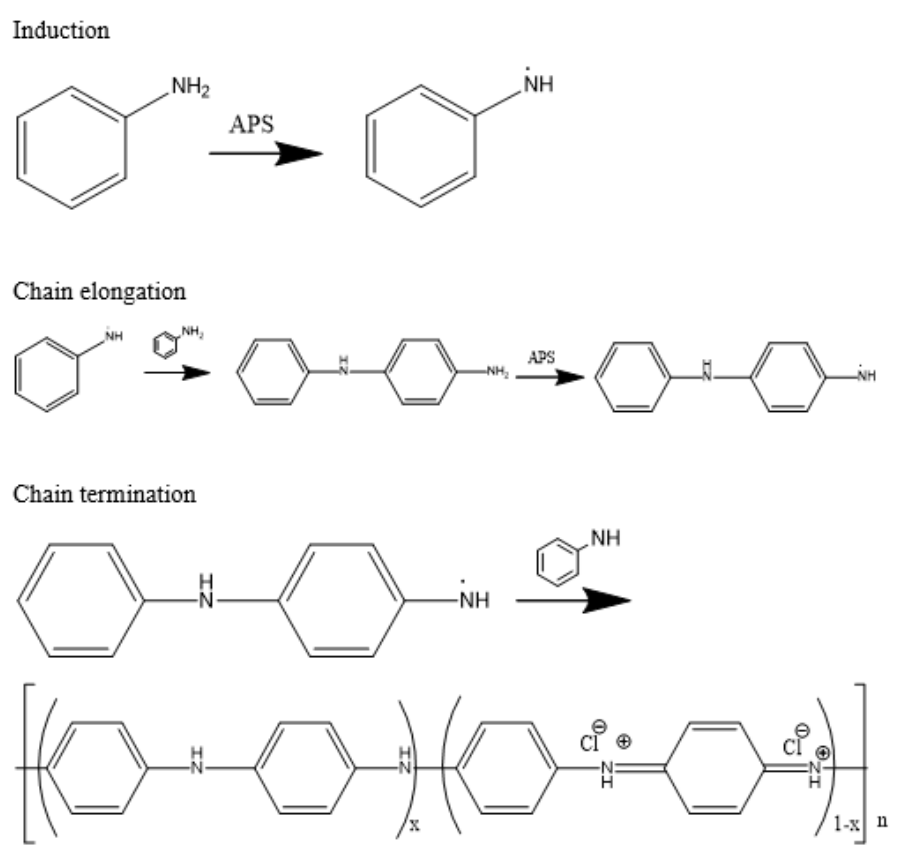
Figure 5. Oxidative polymerisation of aniline into PANI with APS as an